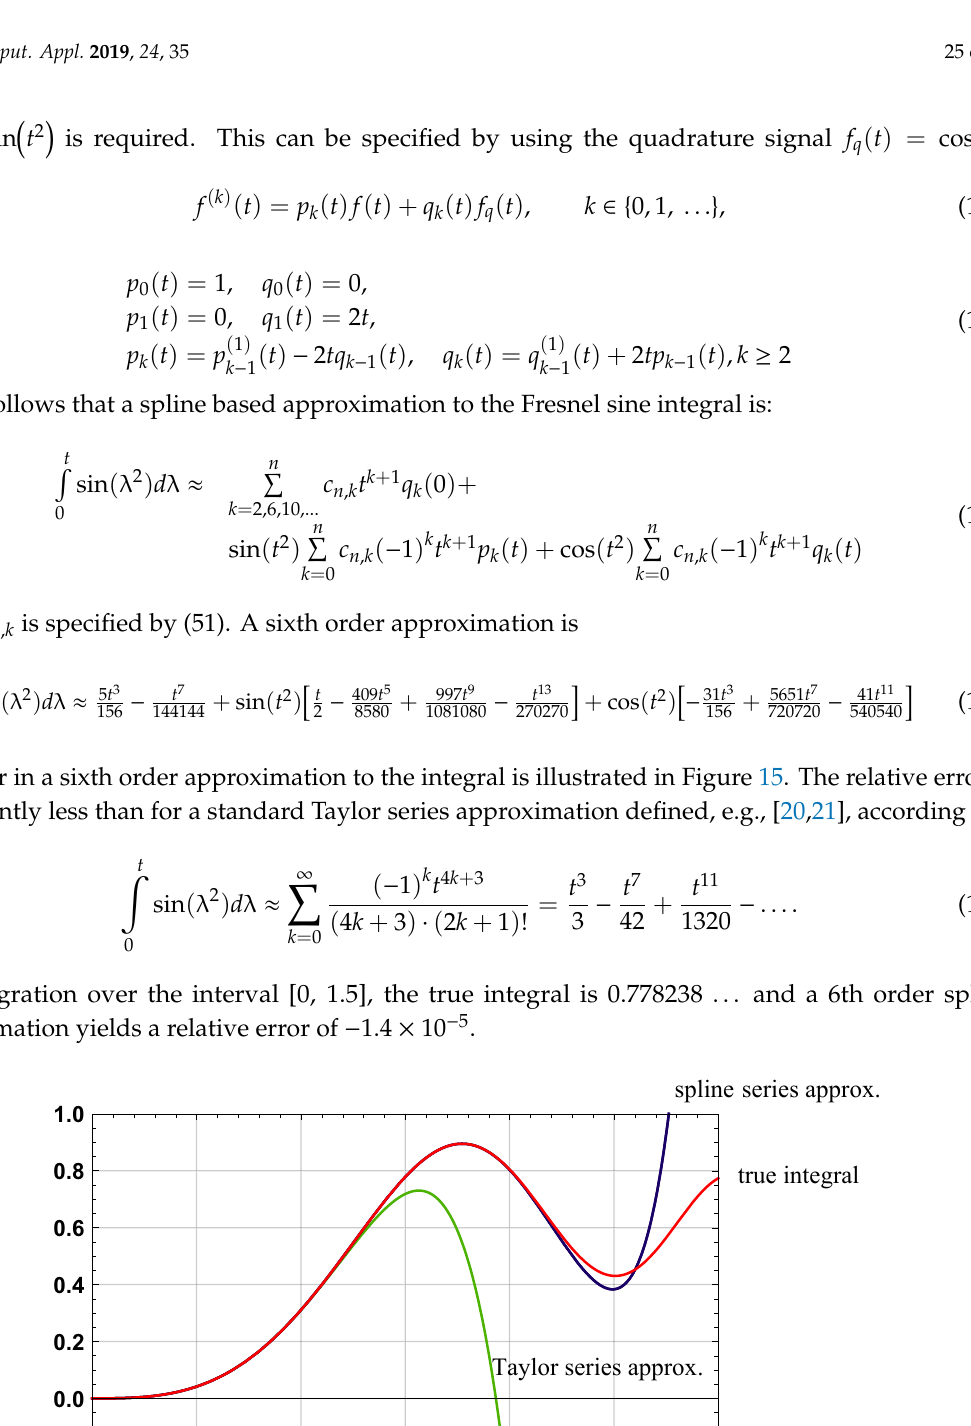
sinTaylor series approx.